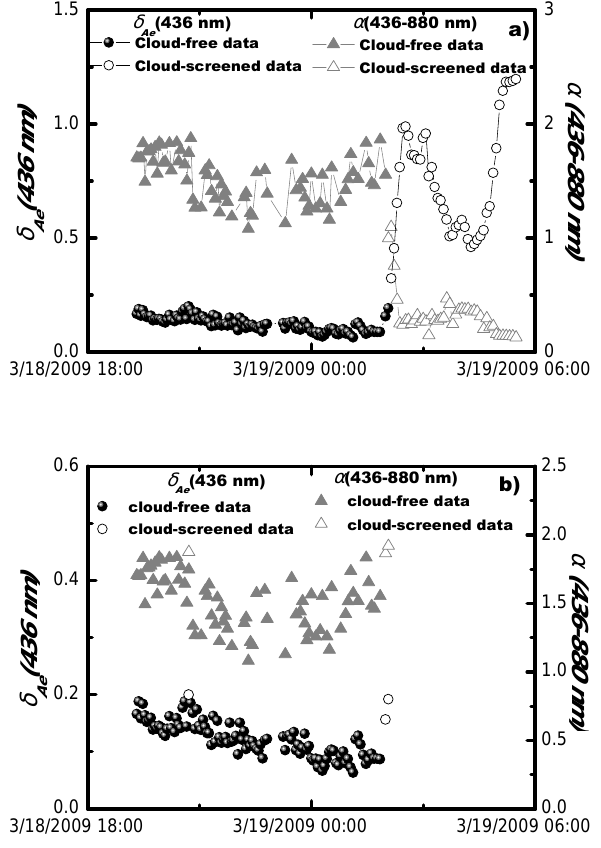
Fig. 3. Temporal evolution of aerosol optical depth at 436nm and Angstr¨om parameter α (436–880nm) from 18 March 2009 at Figure 3: Temporal evolution of aerosol optical depth at 436 nm and Angstrom parameter α 18:00UTC to 19 March 2009 at 06:00UTC. (a) Data series after (436-880 nm) from 18/03/2009 at 18:00 UTC to 19/03/2009 at 06:00 UTC. a) Data series after applying the cloud screening procedure with 1t equal to all-night. applying the cloud screening procedure with ∆ t equal to all-night. b) Data series obtained after (b) Data series obtained after applying moving-average using one- applying moving-average using one-hour-window to the remained data. hour window to the remained